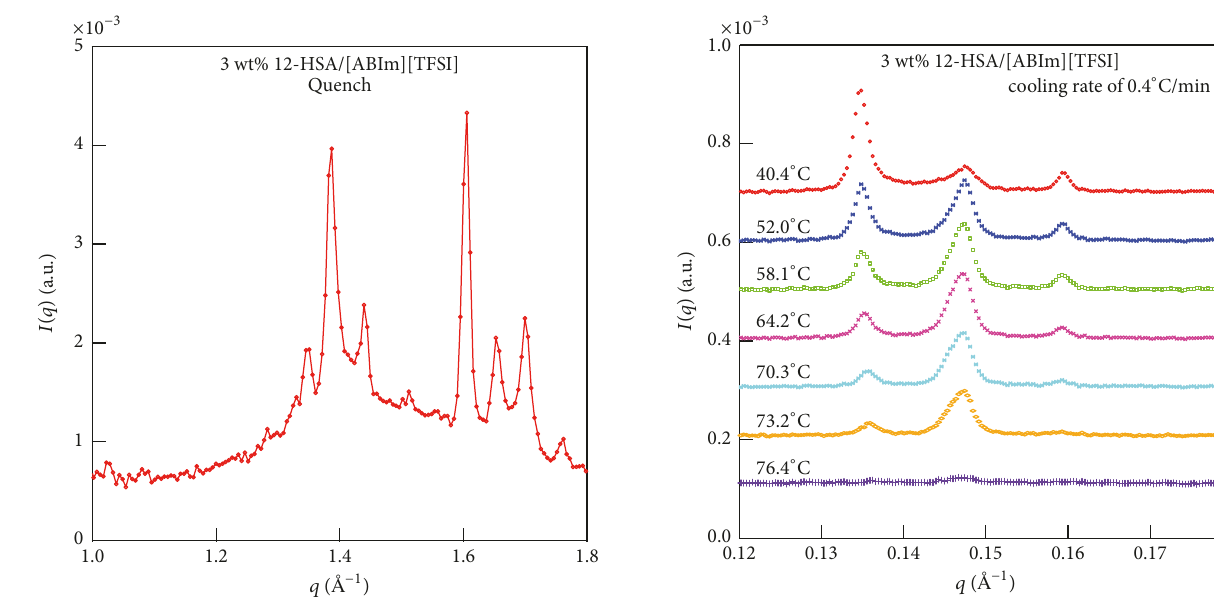
Figure 3: A WAXS profile of 3wt% 12-HSA/[ABIm][TFSI] gel prepared by quench.